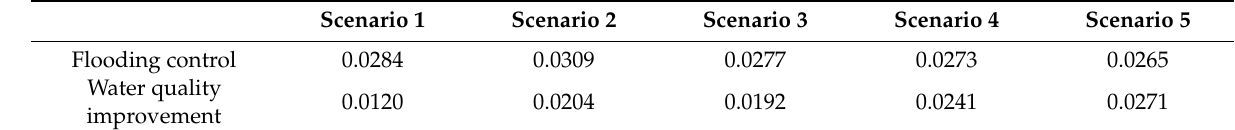
Table 11. The results of flooding control and water quality improvement for scenarios.